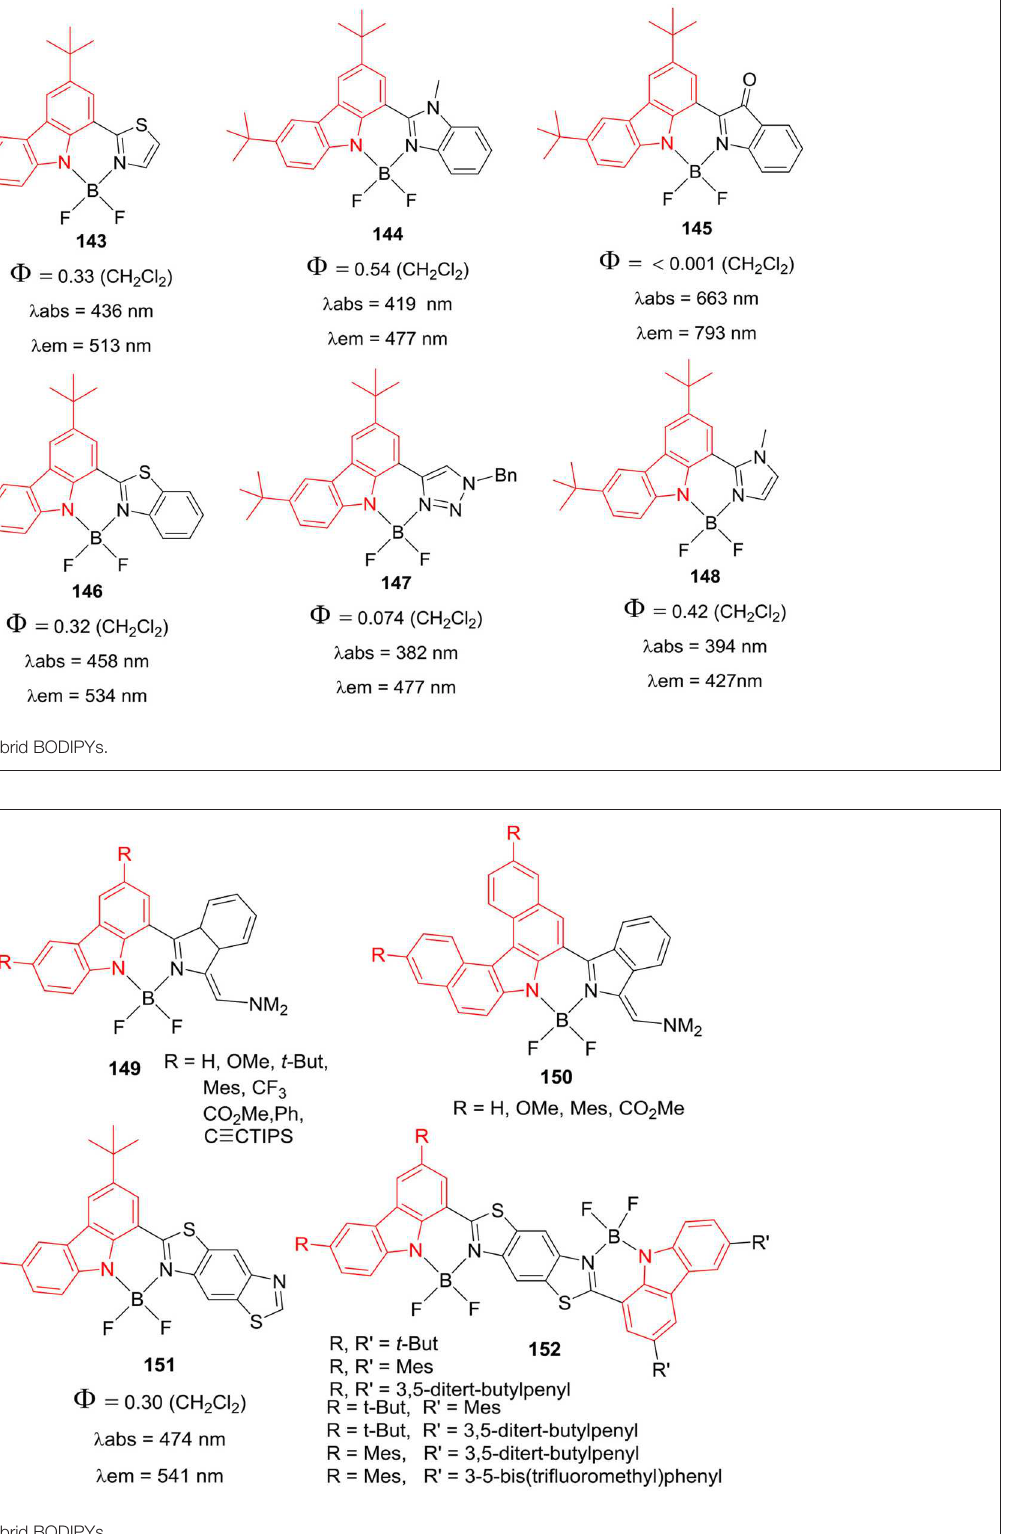
CHART 29 | Carbazole based hybrid